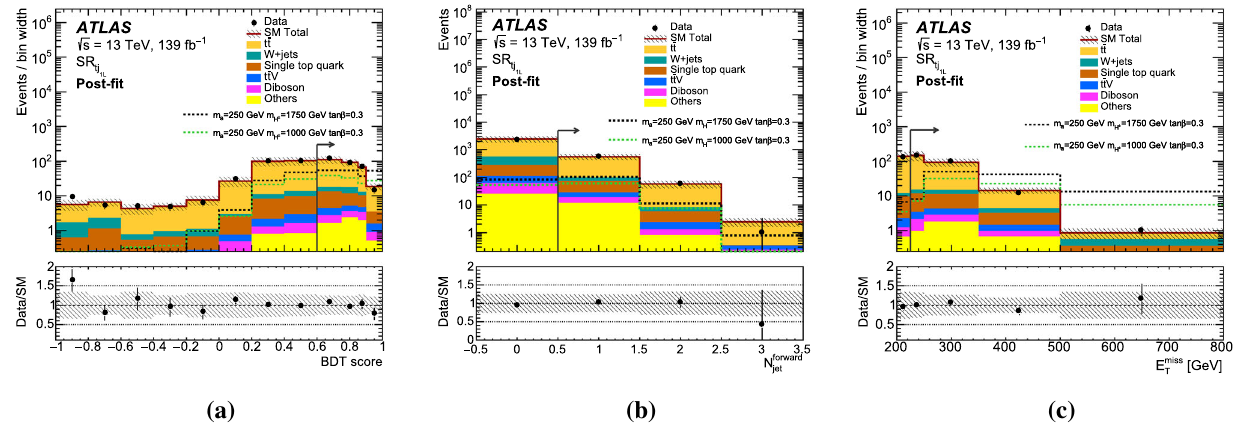
Fig. 12 Representative distributions of a BDT score, b N forward c E miss in the tj 1L channel. Observed data are compared with the SM T background predictions extrapolated from the background-only fit. All